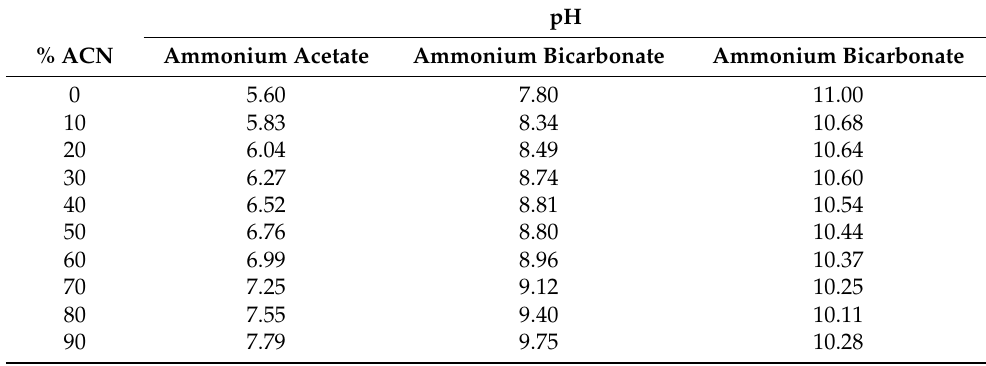
Table 2. Measured pH values of challenge solutions with different acetonitrile (ACN)